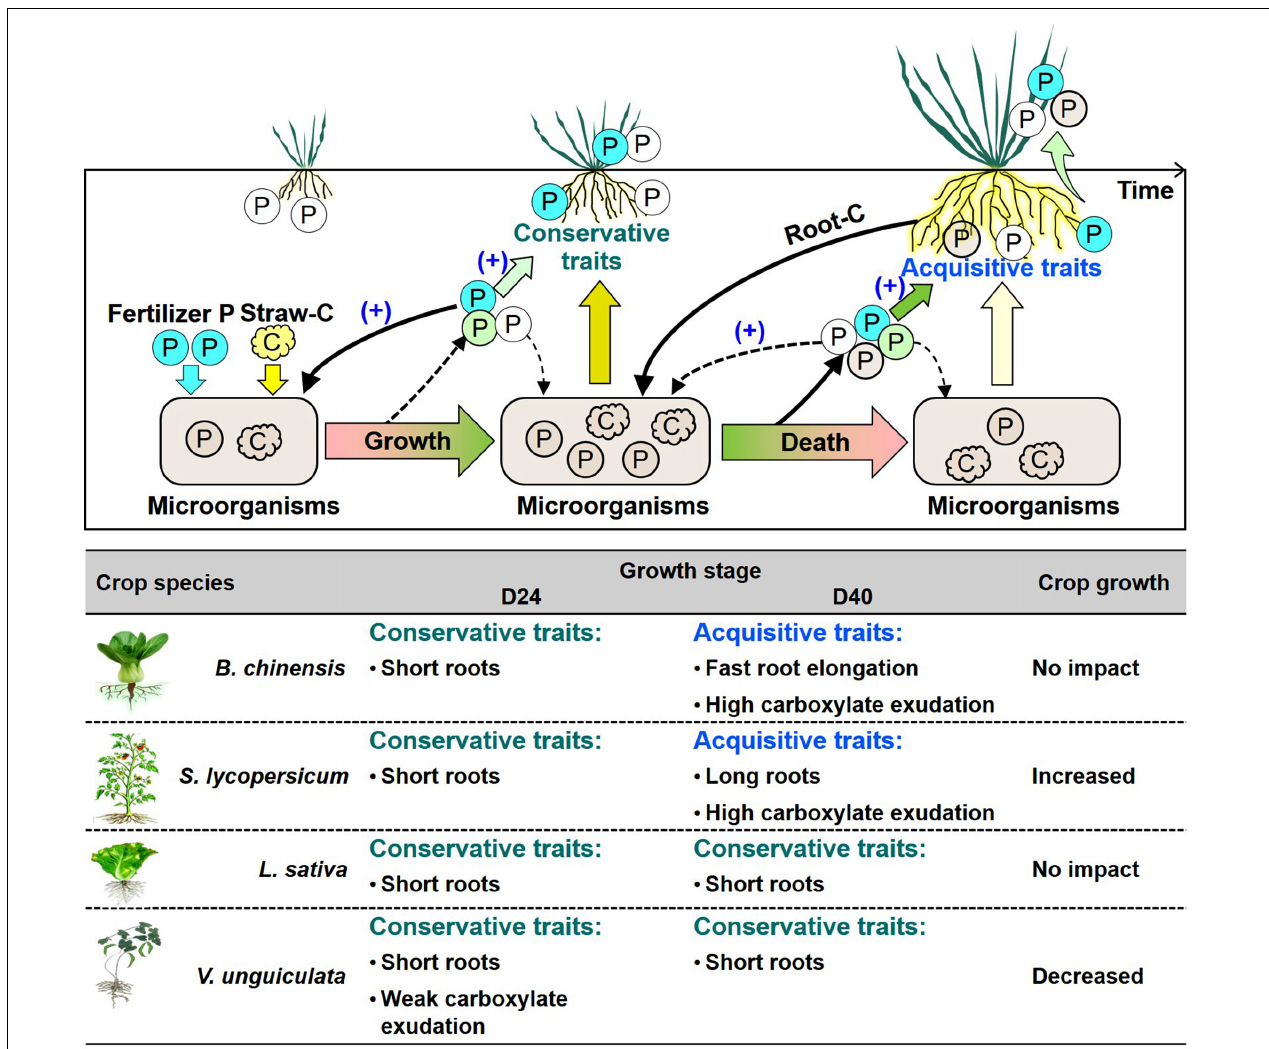
FIGURE 5 | Framework of the root-microbe interactions driven by straw addition and P fertilization as well as the role of these interactions in P uptake by B. chinensis , S. lycopersicum , L. sativa , and V. unguiculata . The solid-line black arrows indicate the strong interactions among soil P, microbes, and roots influencing plant growth, whereas the dashed arrows denote the relatively weak effects. The white circles indicate the available P in soil; the blue circles denote the added fertilizer P; and the pink circles represent the processes of P release from microbial biomass to the plant-available P pool, but no supporting data are available so far. The table denotes the changes in root morphological and exudation traits with straw addition in comparison with roots without straw addition after day 24 (D24) and 40 days (D40). A dark green arrow indicates the strong influence of soil P on root traits, whereas a light green one indicates the weak influence. A light brown arrow indicates the strong influence of microbes on root traits, whereas a light yellow one denotes the weak influence. The plus in parentheses indicates the P fertilization increases the role of P in governing root traits related to crop P acquisition and microbial P